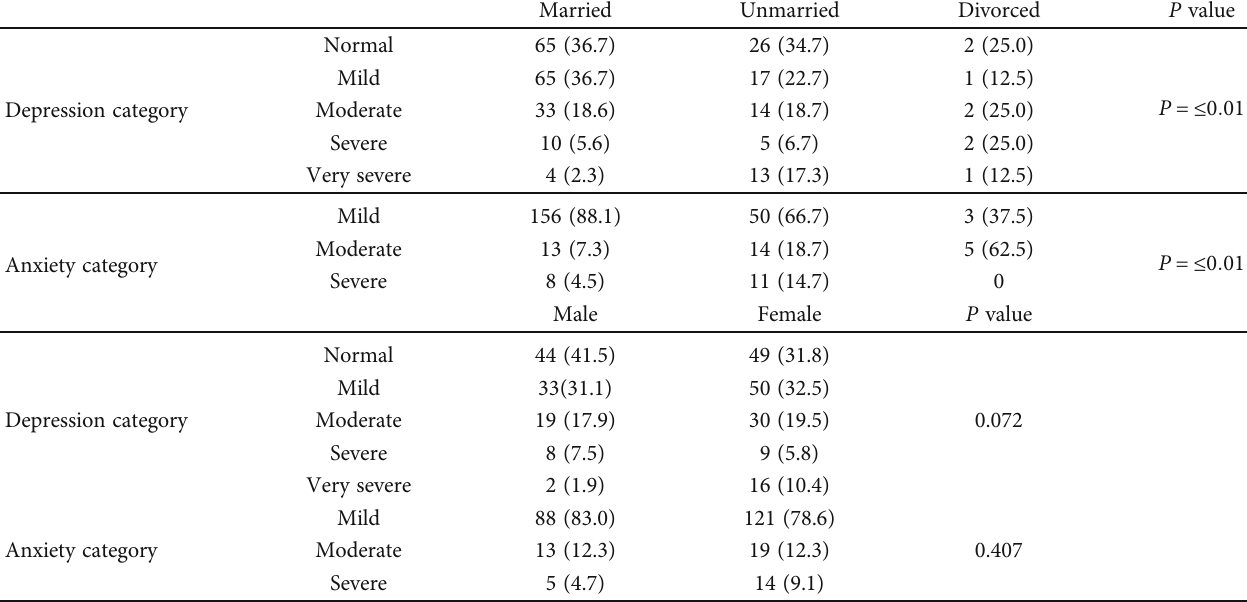
Table 4: Association of marital status and gender with anxiety and depression ( n = 260 ).